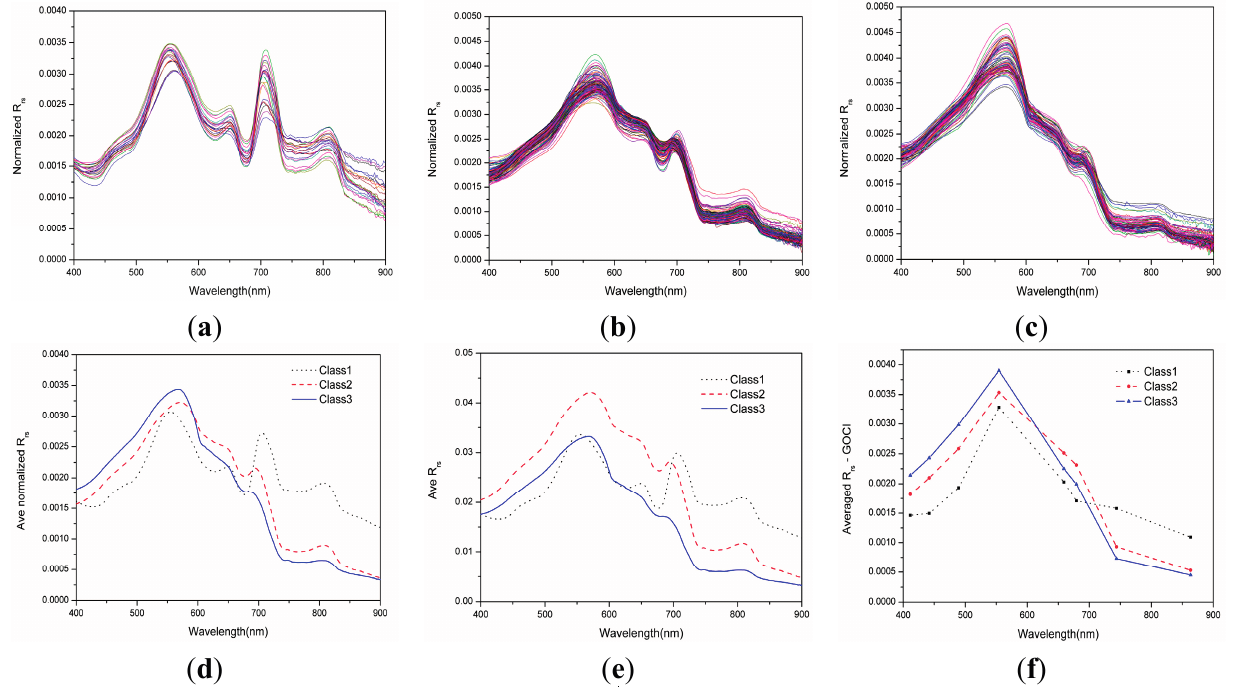
Figure 2. Three types of normalized reflectance spectra based on NMI: ( a ) Class 1; ( b ) Class 2; ( c ) Class 3; ( d ) average normalized reflectance spectra of each type; ( e ) average raw reflectance spectra of each type; and ( f ) normalized spectra resampled to the GOCI